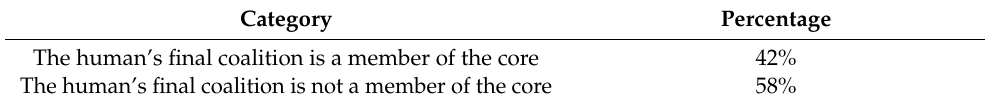
Table 2. Human final coalition compared to the expected core coalition.